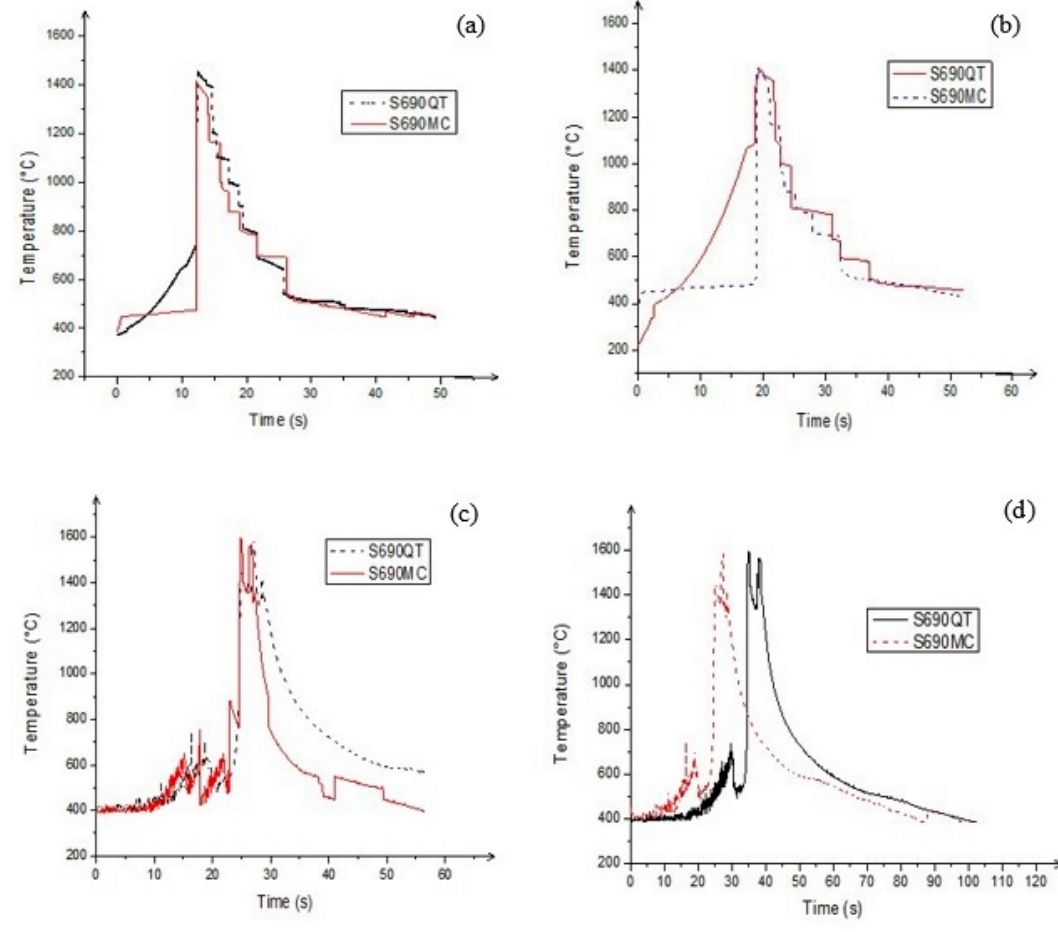
Figure 6. Cooling time results in the weld joint: numerical values using ( a ) 10 kJ/cm of heat input, ( b ) 14 kJ/cm of heat input, and ( c ) 17 kJ/cm of heat input; ( d ) experimental values using 10 kJ/cm of heat input.